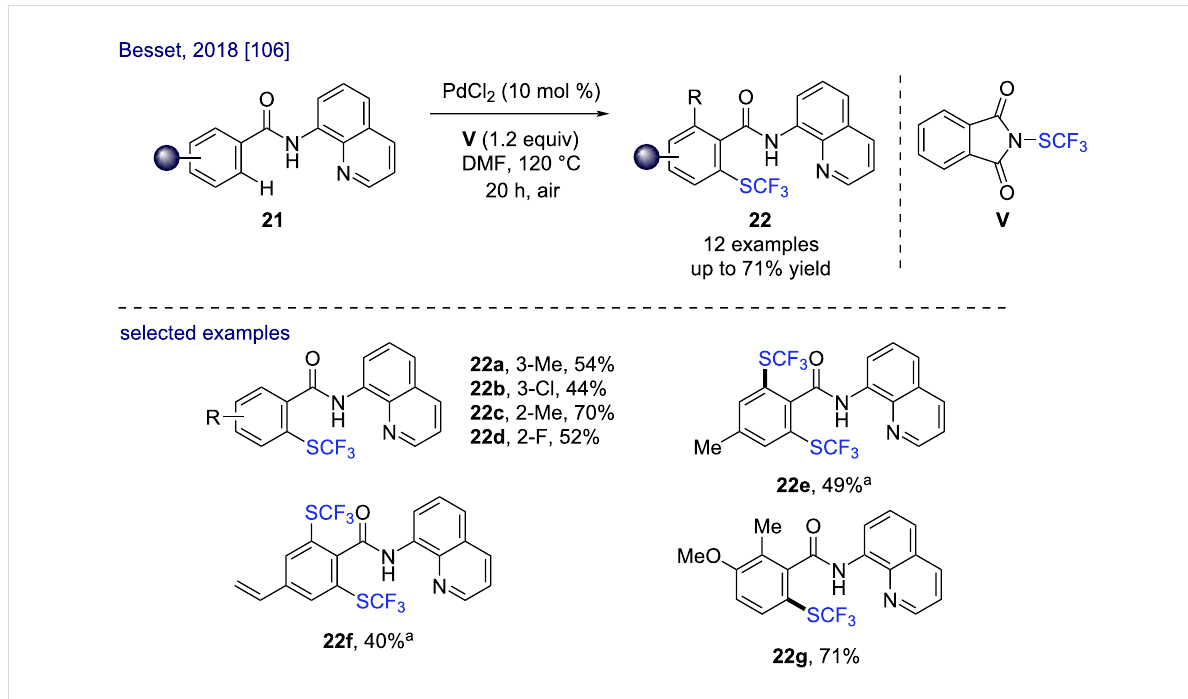
Scheme 9: Mono- and ditrifluoromethylthiolation of benzamide derivatives derived from 8-aminoquinoline using PdCl 2 as catalyst reported by Besset and co-workers [106]. a 2.2 equiv of the fluorinated source V were